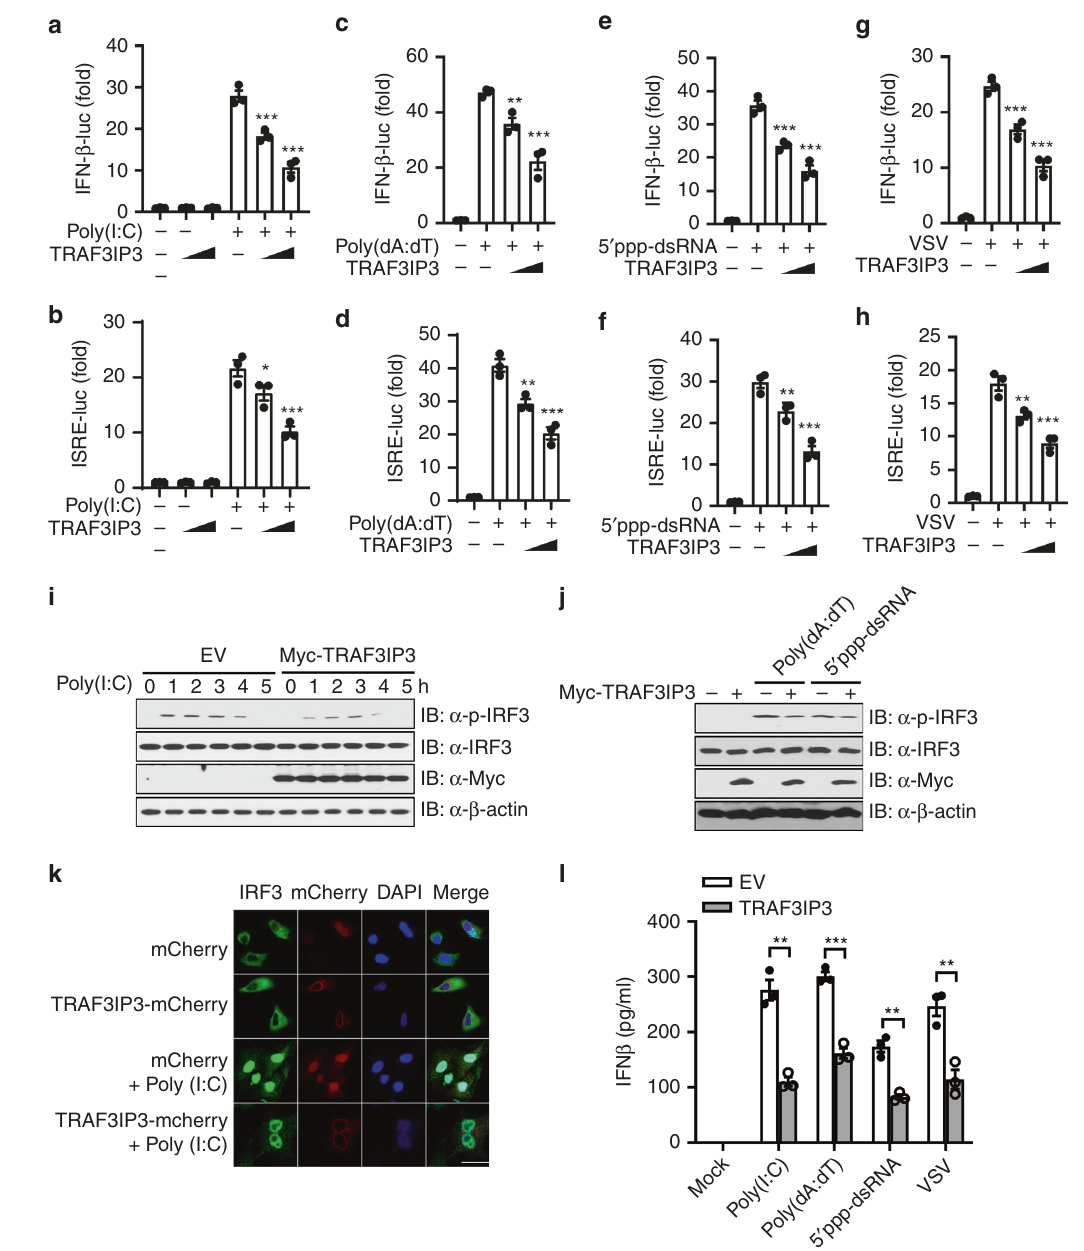
Fig. 1 TRAF3IP3 attenuates the type I interferon response. a – h Luciferase assay conducted in HEK293T cells transfected with increasing Myc-TRAF3IP3 (wedge represents 100 and 200 ng) or empty vector (EV), together with the IFN- β or ISRE reporter for 24 h, followed by mock transfection, transfection of poly(I:C), poly(dA:dT), 5 ′ ppp-dsRNA for 6 h or VSV infection (MOI = 0.5) for 6 h. Renilla luciferase was used as the internal control. i , j Immunoblotting using HEK293T cells transfected with Myc-TRAF3IP3 or empty vector (EV) for 24 h, followed by mock transfection, transfection of poly(I:C) for the indicated time, or transfection of poly(dA:dT) or 5 ′ ppp-dsRNA for 2 h. Densitometry shown in Supplementary Fig. 2c and d. k Immuno fl uorescence of HeLa cells transfected with TRAF3IP3-mCherry or mCherry EV, followed by mock transfection or transfection of poly(I:C) for 3 h. Scale bar, 20 μ M. l IFN- β ELISA using HEK293T cells transfected with Myc-TRAF3IP3 or EV, followed by mock transfection, transfection of poly(I:C), poly(dA:dT), 5 ’ ppp-dsRNA for 9 h or VSV infection (MOI = 0.5) for 9 h. Data are presented as mean ± SEM and are one representative of three independent experiments. a – h One-way ANOVA followed by Dunnet post hoc correction. l t -test. ∗ p < 0.05, ∗∗ p < 0.01, ∗∗∗ p < 0.001. Source data are provided as a Source Data fi le. TRAF3IP3. Pro fi ling of TRAF3IP3 expression in human cell protein levels in THP-1 cells, and the lack of expression in lines using the Human Protein Atlas revealed the enriched HEK293T or HeLa cells (Fig. 2a). The endogenous TRAF3IP3 TRAF3IP3 expression in T and B cell lines as well as several expression in THP-1 cells was similar to that of Jurkat T cells, myeloid cell lines such as THP-1 and HL60 cells, but not in paralleling its expression in primary T and myeloid cells. other commonly used stromal cell lines such as HEK293 or HEK293T overexpressing TRAF3IP3 was used as a positive HeLa cells and most other cell lines (Supplementary Fig. 3a). control for antibody speci fi city, while HEK293T cells served as We con fi rmed the expression of TRAF3IP3 at both mRNA and a negative control. NATURE COMMUNICATIONS| (2020) 11:2193